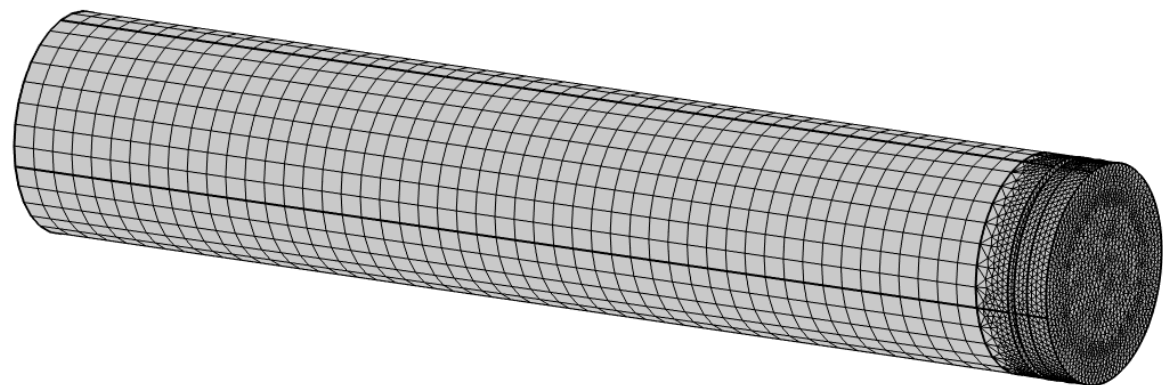
Acoustics 2022 , 4 FOR PEER REVIEW Figure 4. Finite element mesh of the computational domain. Figure 4. Finite element mesh of the computational domain.